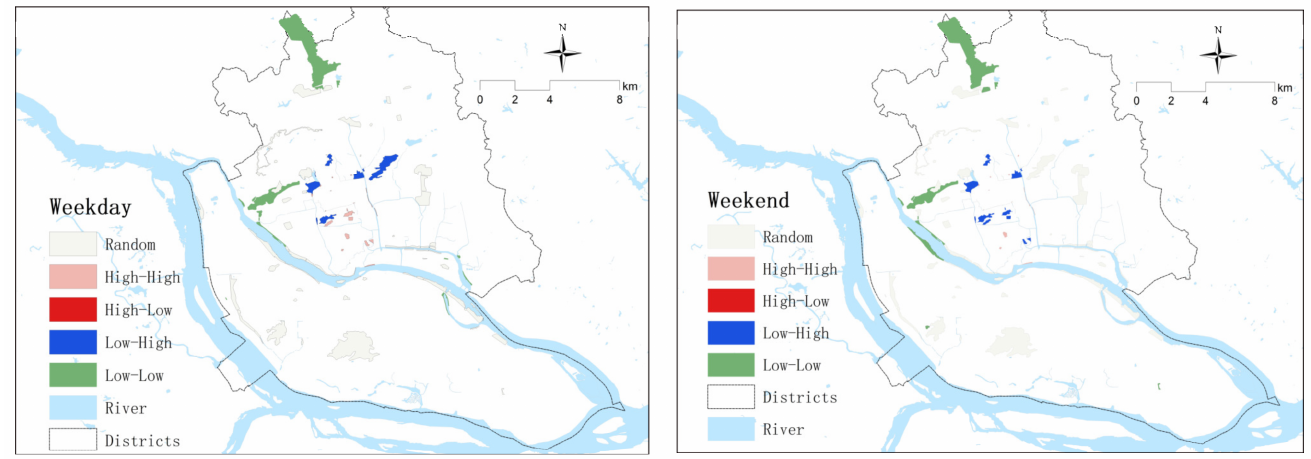
Figure 4. Local indicators of spatial association (LISAs) map of park use density (PUD) in